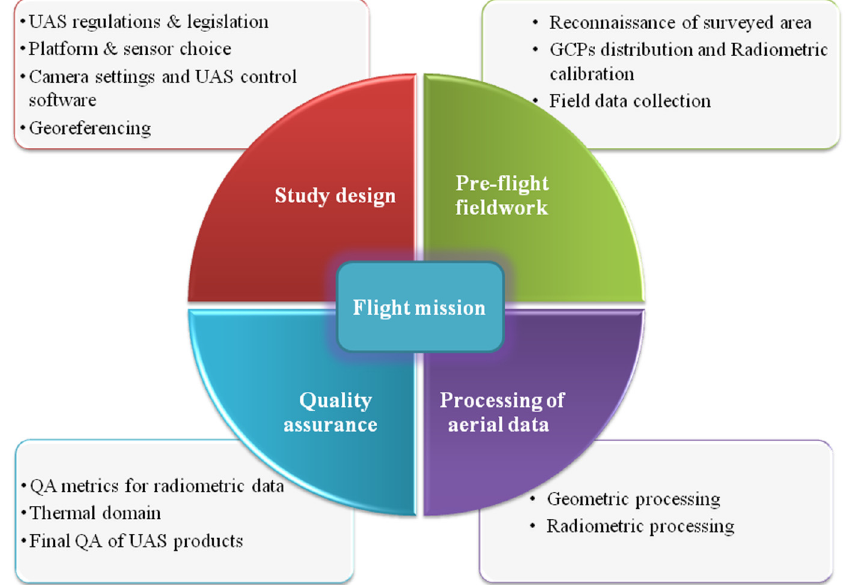
Figure 1. Activities involved in UAS-based mapping. The five topics identified in this graph also reflect the structure of the present manuscript that addresses each of them in the following